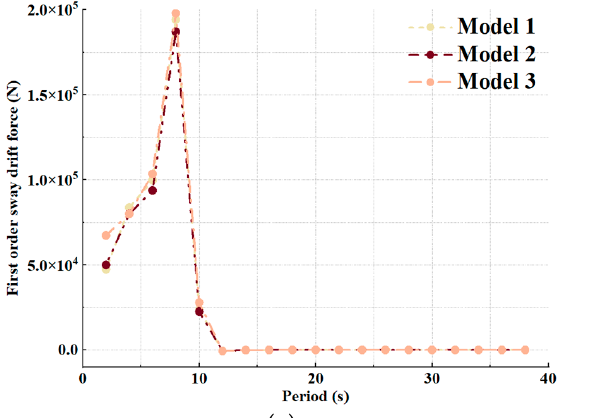
Figure 5. Mesh convergence verification. ( a ) First-order heave motion; ( b ) First-order pitch motion; ( c ) First-order roll motion; ( d ) First-order roll moment; ( e ) Mean drift force in the sway by the far- field method; ( f ) Mean drift force in the sway by direct pressure integral method.